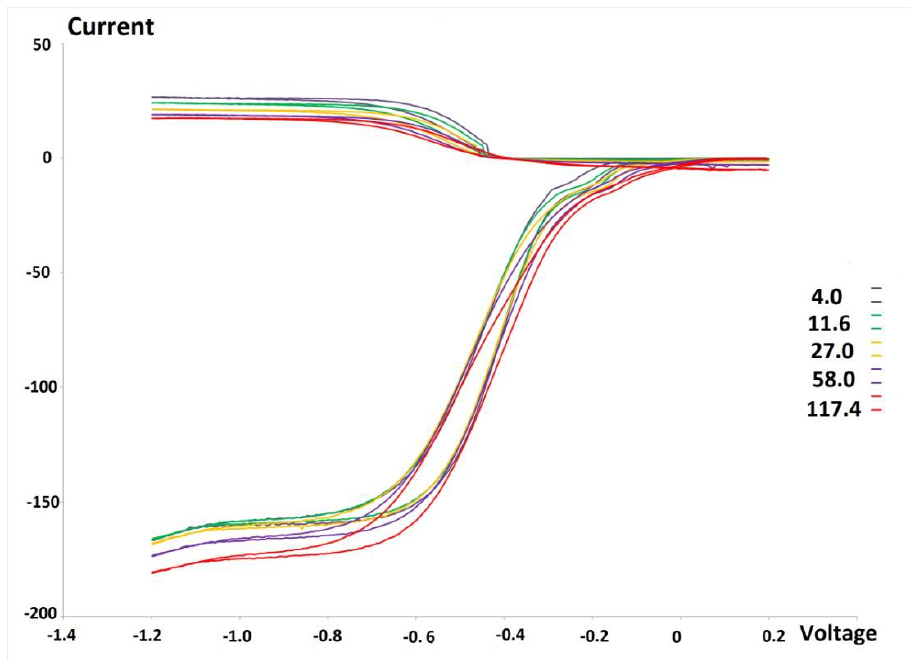
Figure 2. RRDE graph of 2,5-dimethoxybenzoquinone (DMBQ). Colors are associated with (10 − 5 ) specific molarity, for instance, the maximum concentration is 117.4 × 10 − 5 M (red color), and the whole range is 4.0–117.4 × 10 − 5 M. Voltage measured in volts, Currency in µ A.